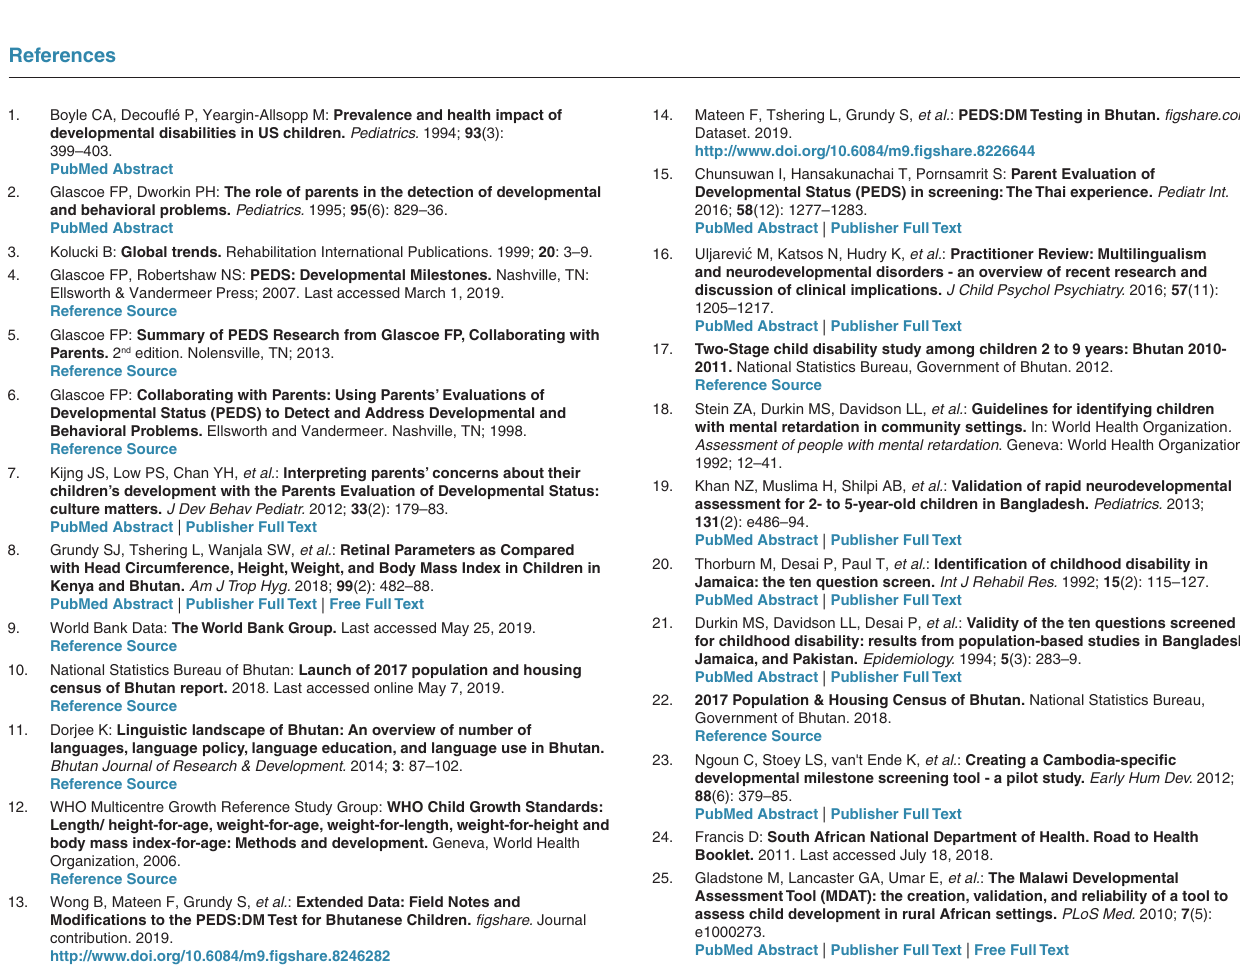
Figshare: Extended Data: Field Notes and Modifications to